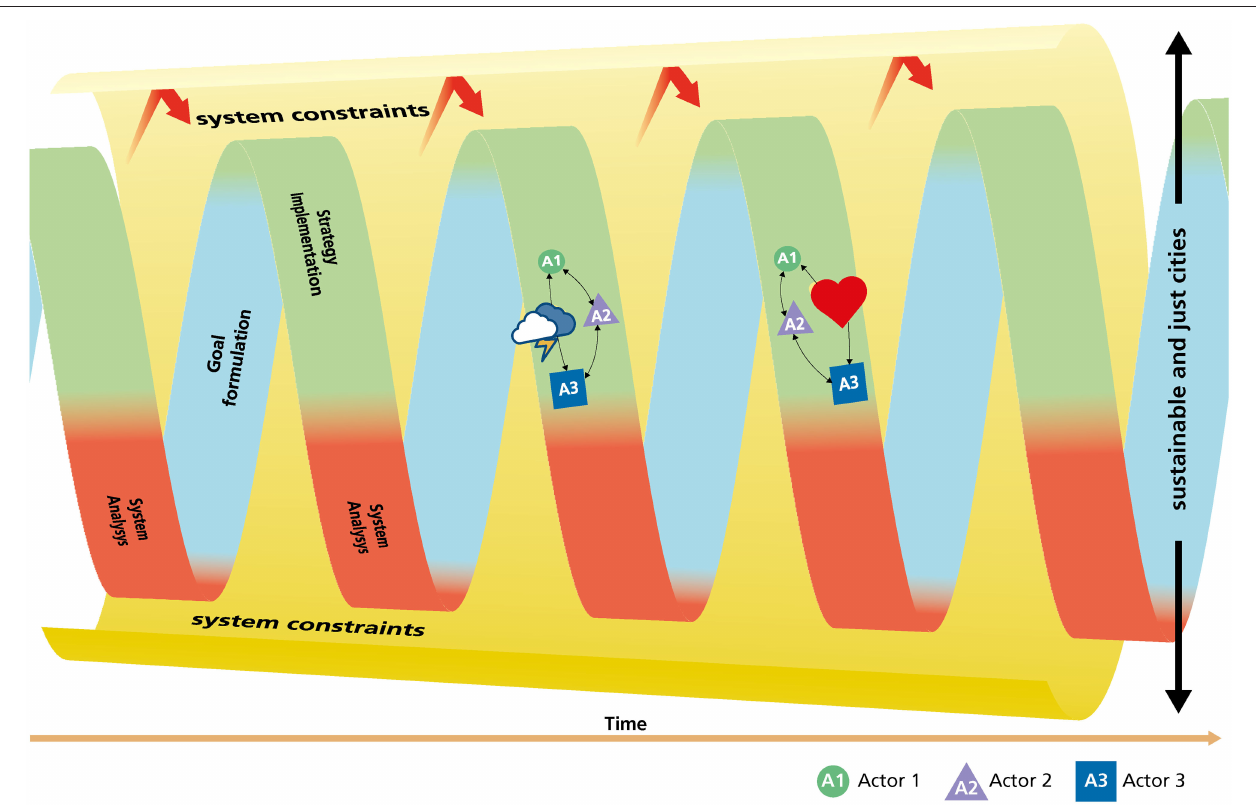
FIGURE 2 | Reflexive governance for sustainable and just cities involves an iterative process of system analysis, goal formulation, and strategy formulation. For an initiative at the microscale to contribute to sustainable and just cities at the meso- and macro-scale, power struggles with system structures maintaining the status quo are required. Effects of such struggles may only emerge over a longer time horizon. To maintain reflexive governance over time, there may also be a need for actors within a particular initiative to confront each other, especially if an initiative includes actors who are strongly tied up in system structures.